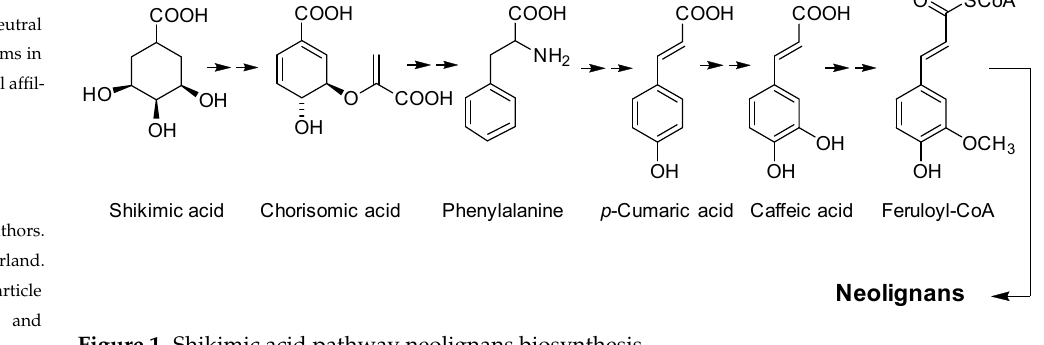
Figure 1. Shikimic acid pathway neolignans biosynthesis.